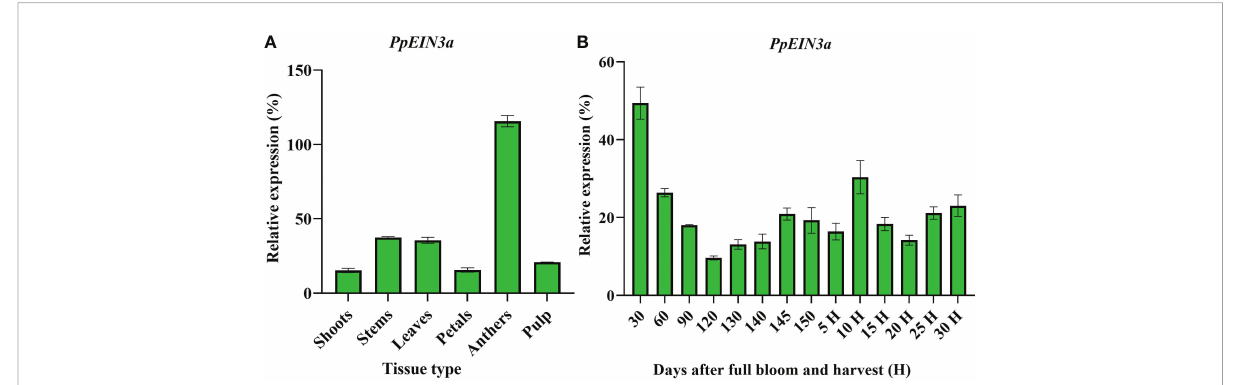
FIGURE 3 Real-time quantitative PCR analyses of PpEIN3a expressions in different pear tissues (A) and during fruit development (B) . Total RNA was isolated from different tissues (e.g., shoots, young stems, young leaves, petals, anthers, and pulp) and during fruit development. The relative value of the PpEIN3a expression in pear is shown as a percentage of actin expression activity. The mean values and SD (bar) from three independent experiments are shown. The values shown are the means ± SD for three replicates.